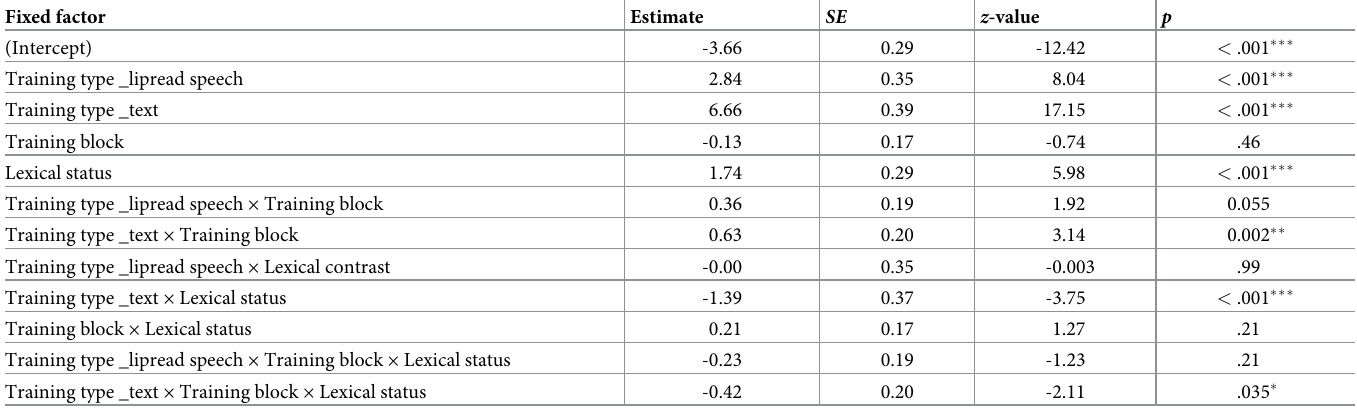
Table 2. Fixed effect coefficient estimates for the generalized linear mixed effects model fitted on the training data. Correct ~ 1 + Training type × Training block × Lexical status + (1 | subject) + (1 |